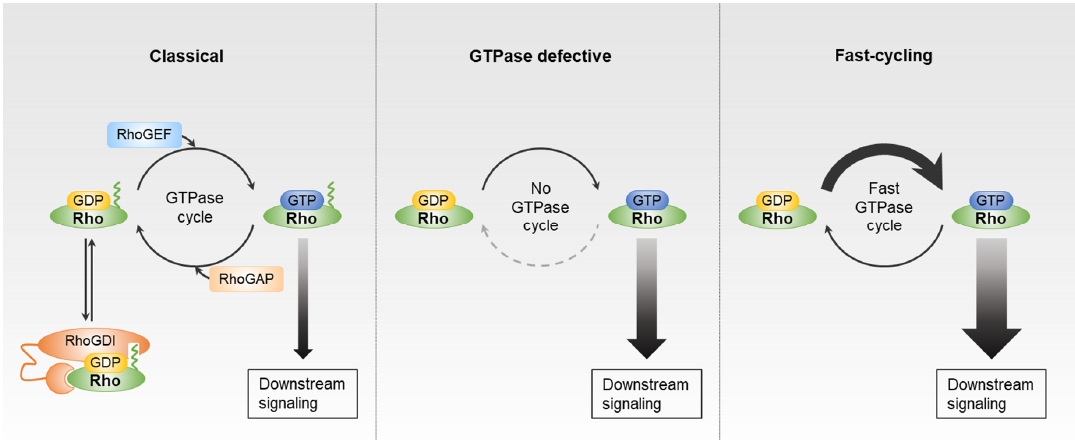
Figure 1. Guanosine diphosphate (GDP)-guanosine triphosphate (GTP) exchange cycle of Rho GTPases. Classic Rho GTPases, such as Rho, Rac, and Cdc42 subfamilies, follow GDP/GTP cycling regulated by Rho guanine nucleotide exchange factors (RhoGEFs), Rho GTPase-activating proteins (RhoGAPs), and Rho guanine nucleotide dissociation inhibitors (RhoGDIs). Rnd and RhoBTB subfamilies cannot be accelerated by RhoGAPs. The RhoU/RhoV and RhoD/RhoF subfamilies have high intrinsic GTP/GDP exchange activity.